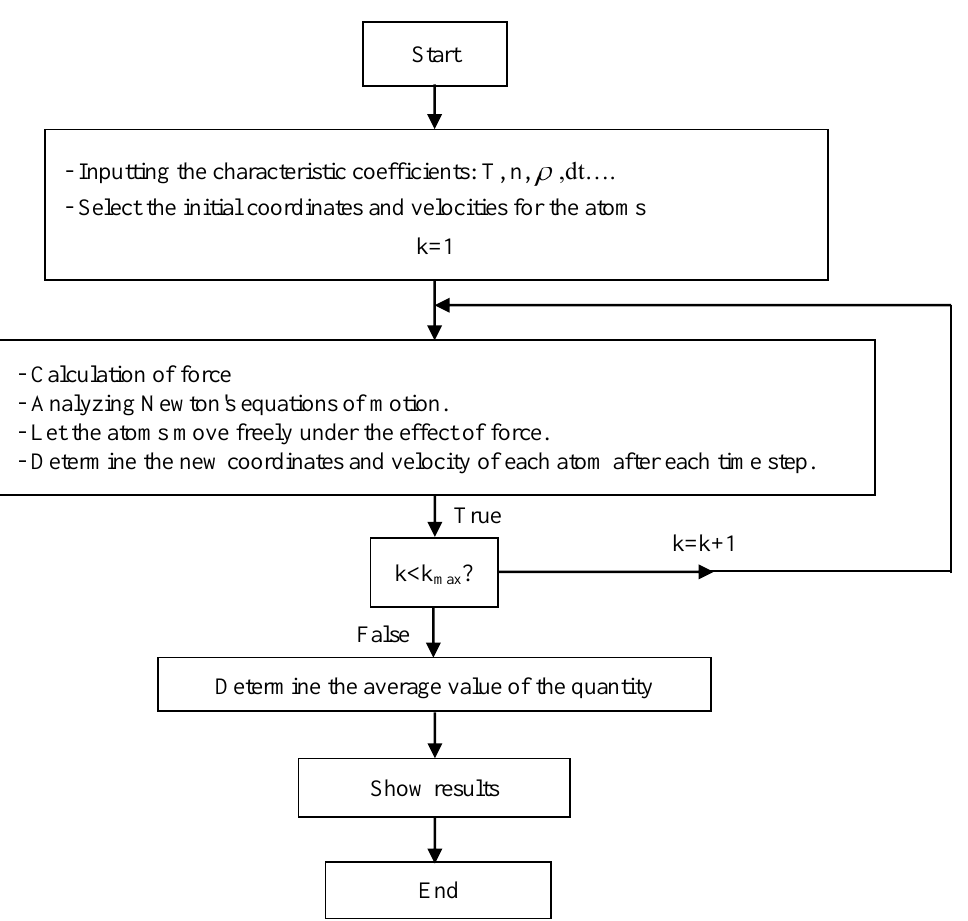
Figure 1. Flowchart of molecular dynamics simulation